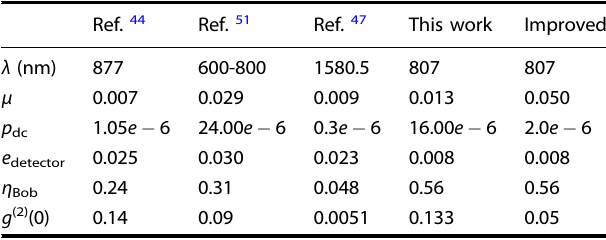
of-the-art SPS-based QKD free-space implementations for quantum dots 44 , color centers in diamond 51 , fi ber-based implementation for quantum dots 47 , and this